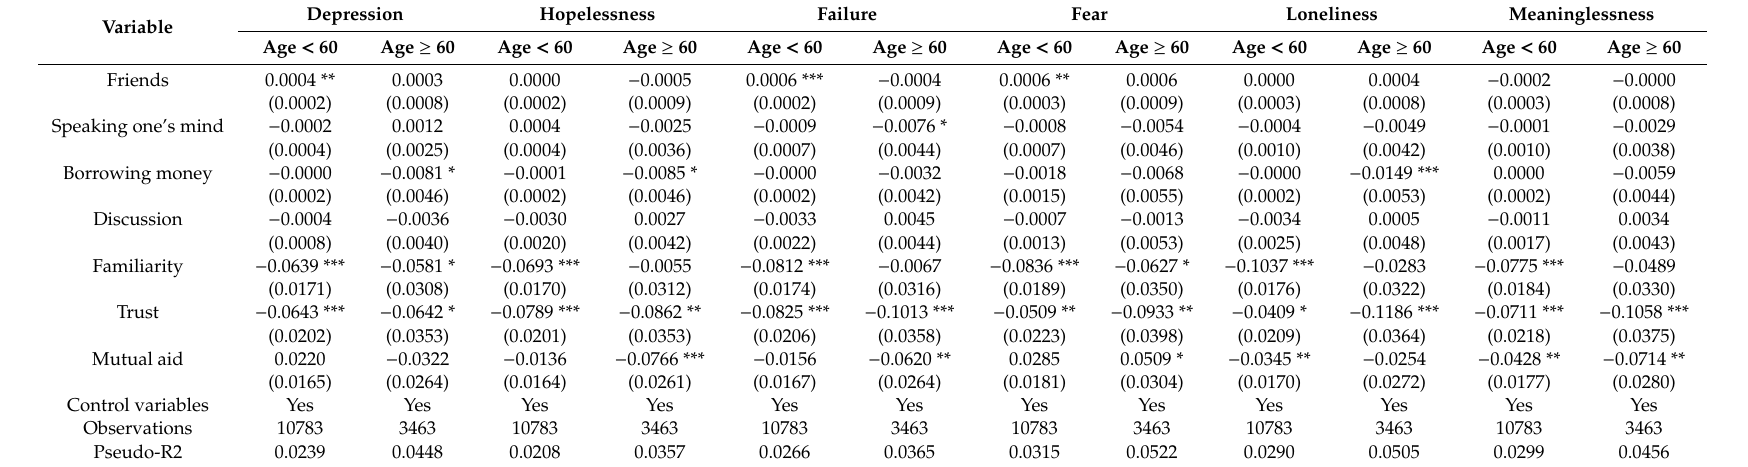
Table 4. Influence of social support on mental health in di ff erent age groups ( N =